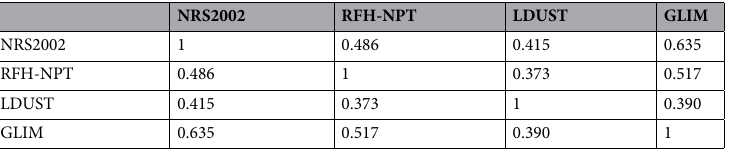
Table 2. Spearman correlation coefficients of different tools. NRS2002 nutritional risk screening 2002, RFH- NPT royal free hospital-nutritional prioritizing tool, LDUST liver disease undernutrition screening tool, GLIM global leadership initiative for malnutrition.